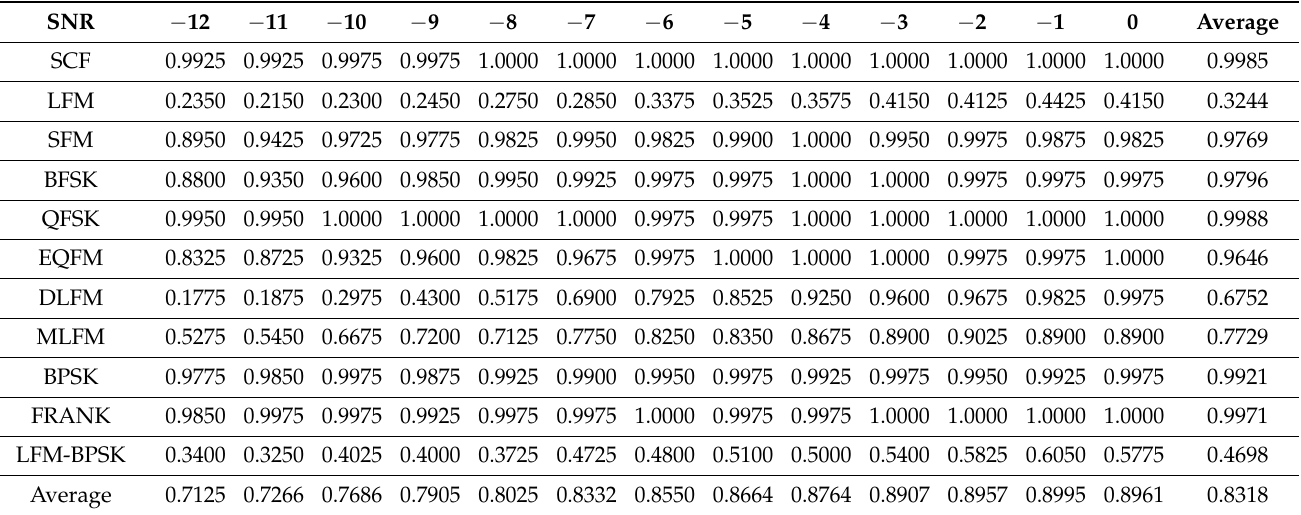
Table A18. Semi-supervised classification results with the datasets in Situation Dataset 4 without self-paced data augmentation ( T cycle = 200, NUM = 276).